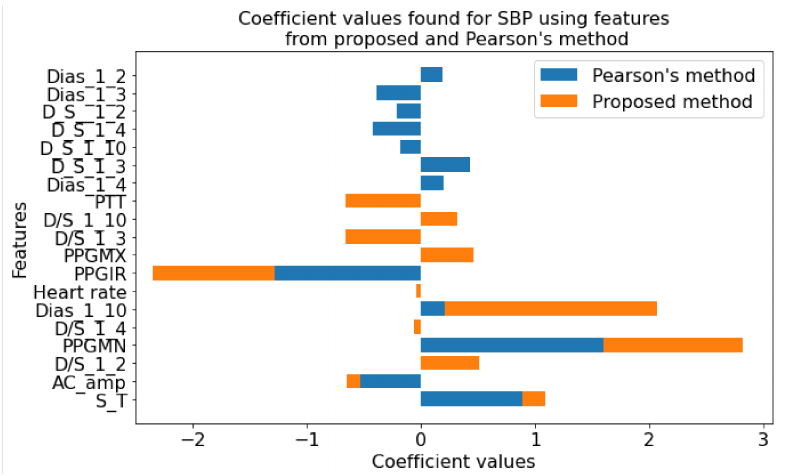
Figure 17. Coefficient values found for SBP using features from proposed method and Pearson’s